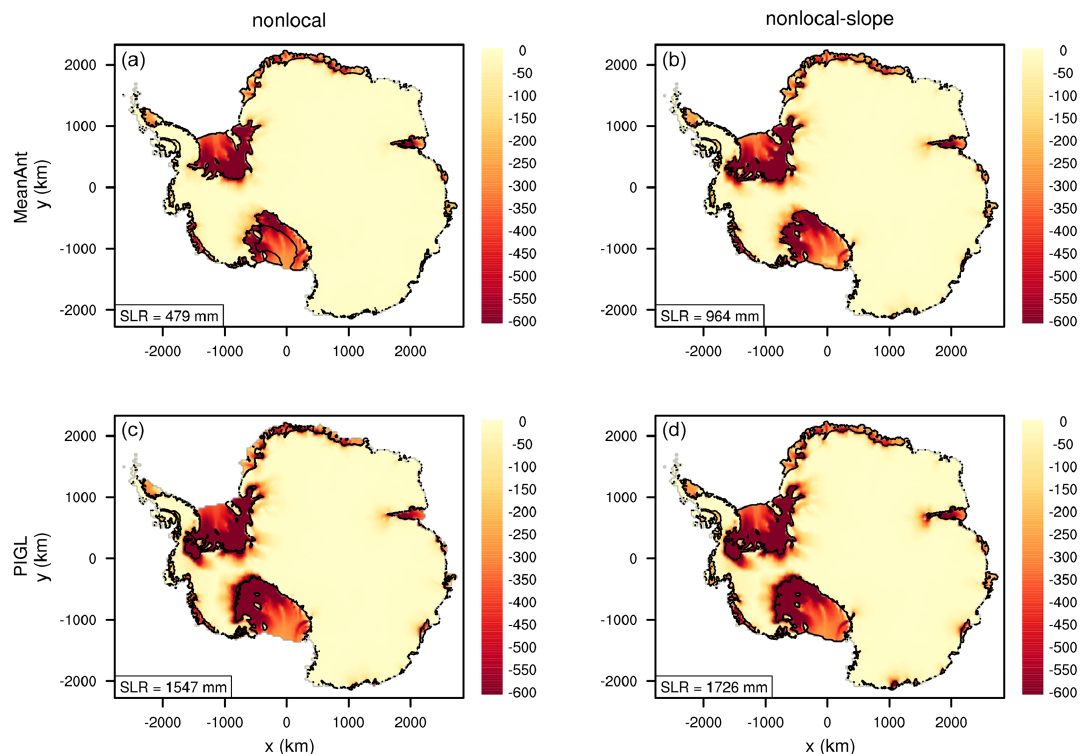
Figure 7. Difference in ice thickness (m) between the years 2500 and 1950 in experiments with idealized ocean forcing. Starting from the spun-up state, thermal forcing increases by 1 ◦ C between 1950 and 2100 and is held fixed thereafter. The two columns correspond to the nonlocal and nonlocal-slope melt parameterizations, and the two rows to the MeanAnt and PIGL calibrations. Black lines show boundaries of floating ice at the end of each run. In the nonlocal-PIGL run (c) , black lines at the present-day calving fronts of several large ice shelves are absent, indicating shelf collapse. In the nonlocal-MeanAnt run (a) , the Ross Ice Shelf partly collapses. Boxes in the lower left of each panel show the SLR contribution from the loss of grounded